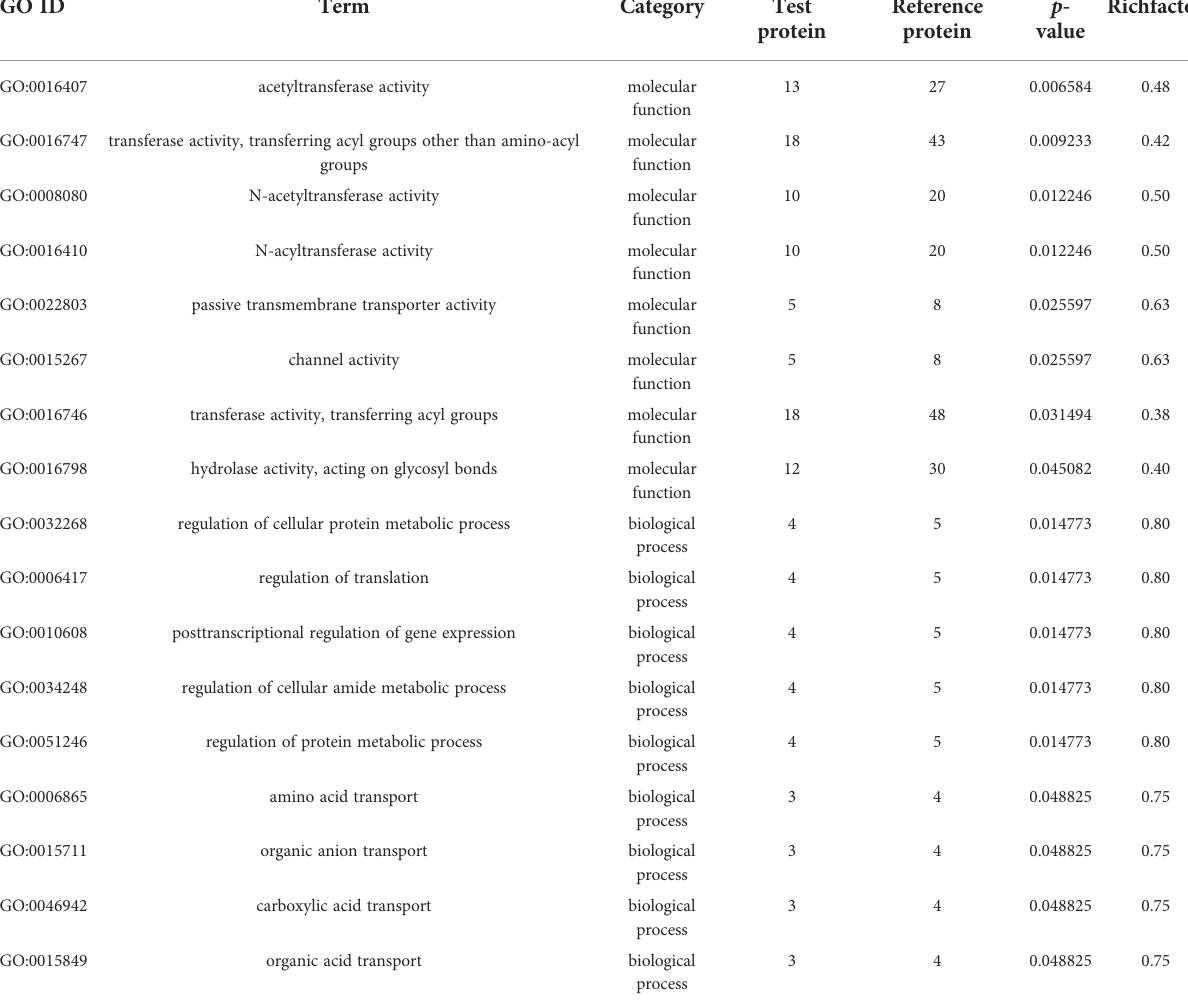
TABLE 3 GO enrichment on ontologies for biological process and molecular function of SC19 treated by